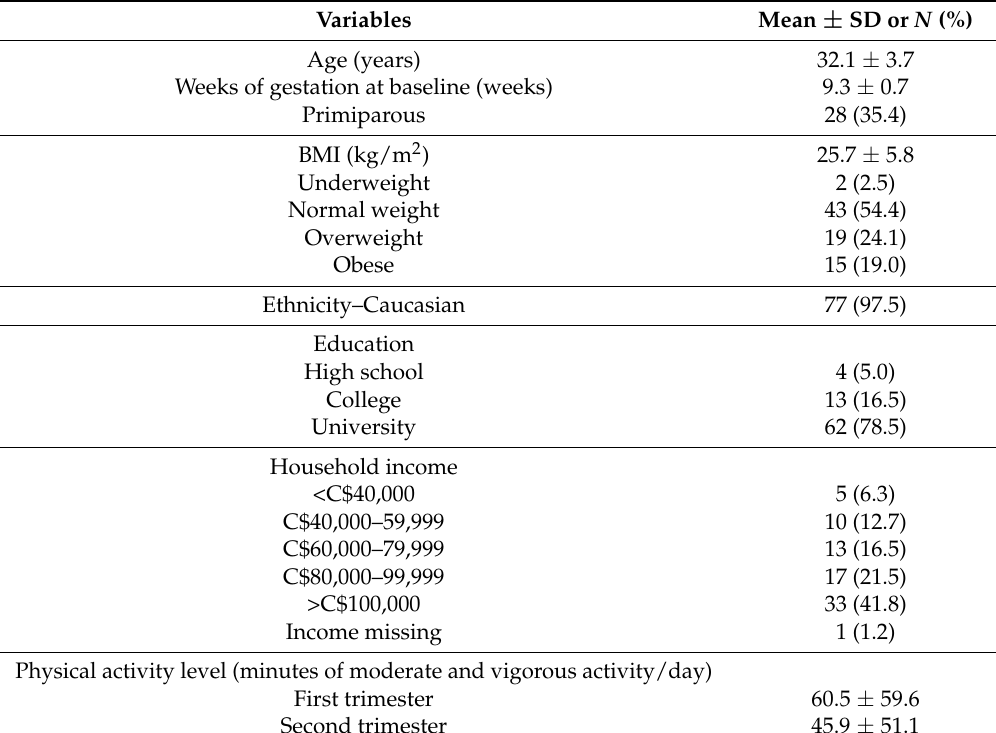
Table 1. Participants’ characteristics ( n =